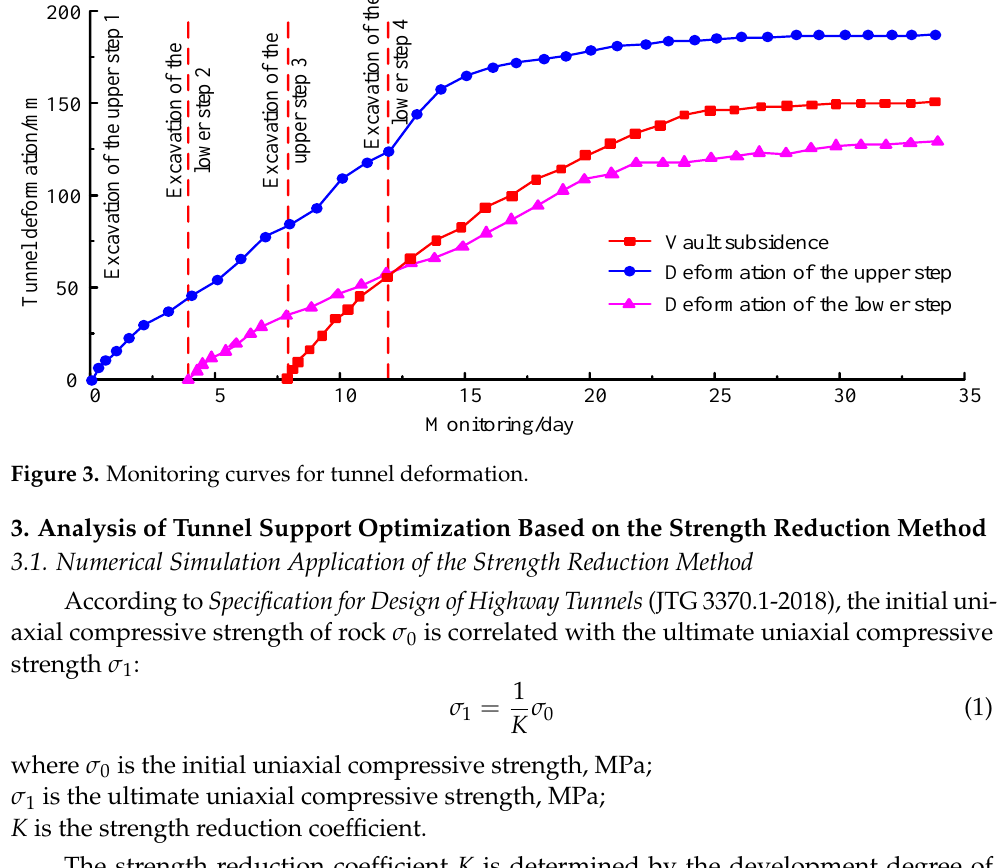
Figure 2. Layout of measuring points for the tunnel. A is the vault subsidence monitoring point. B and C are the horizontal convergence monitoring points of the upper step of the tunnel. D and E are the horizontal convergence monitoring points of the lower step of the tunnel.